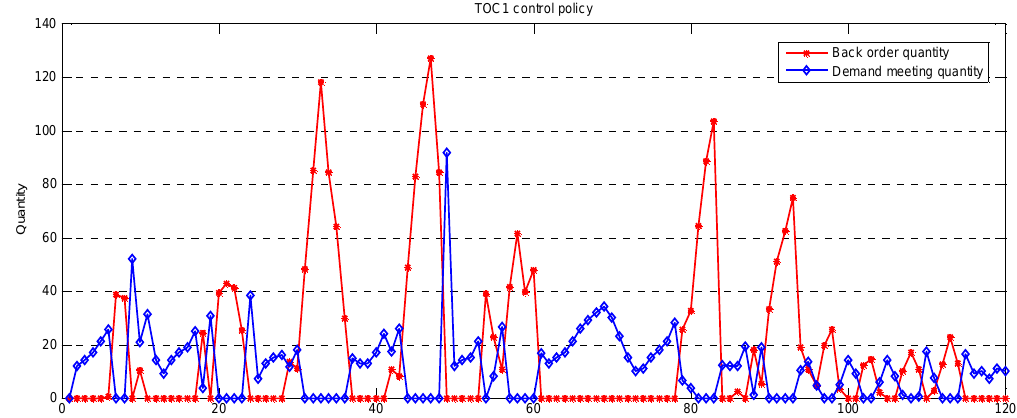
Fig.10. Back order and Demand meeting curve of TOC1 control